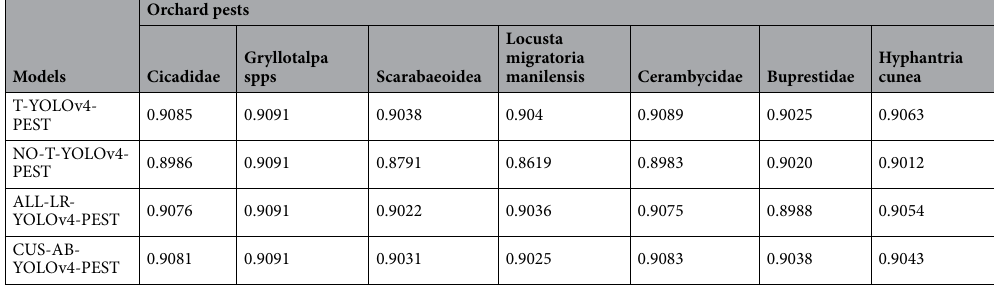
Table 6. The category detection AP of each model (IoU =